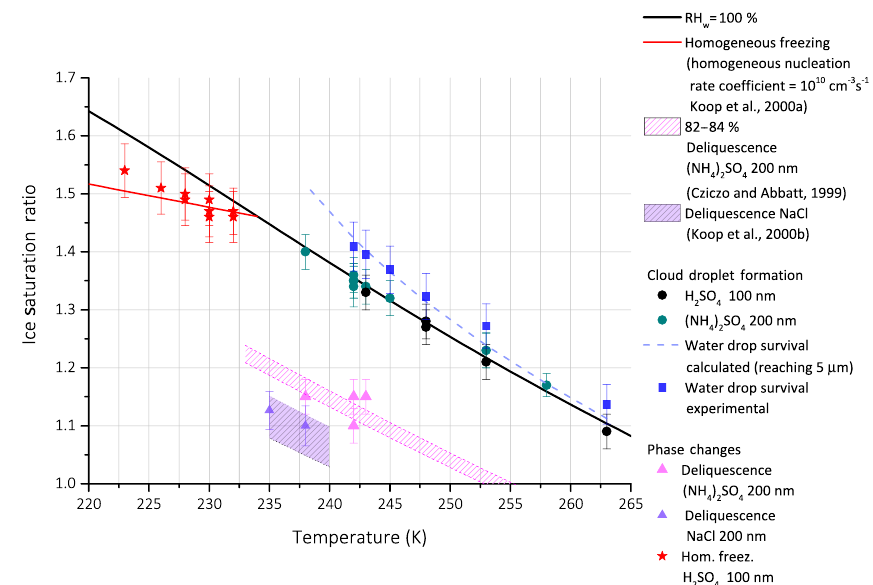
Figure 6. Summary of characterization experiments and comparison to literature and theoretical values of phase changes and growth pro- cesses. Data from experiments reflect the first appearance of ice (ice onset) when the AF increases above the chamber background